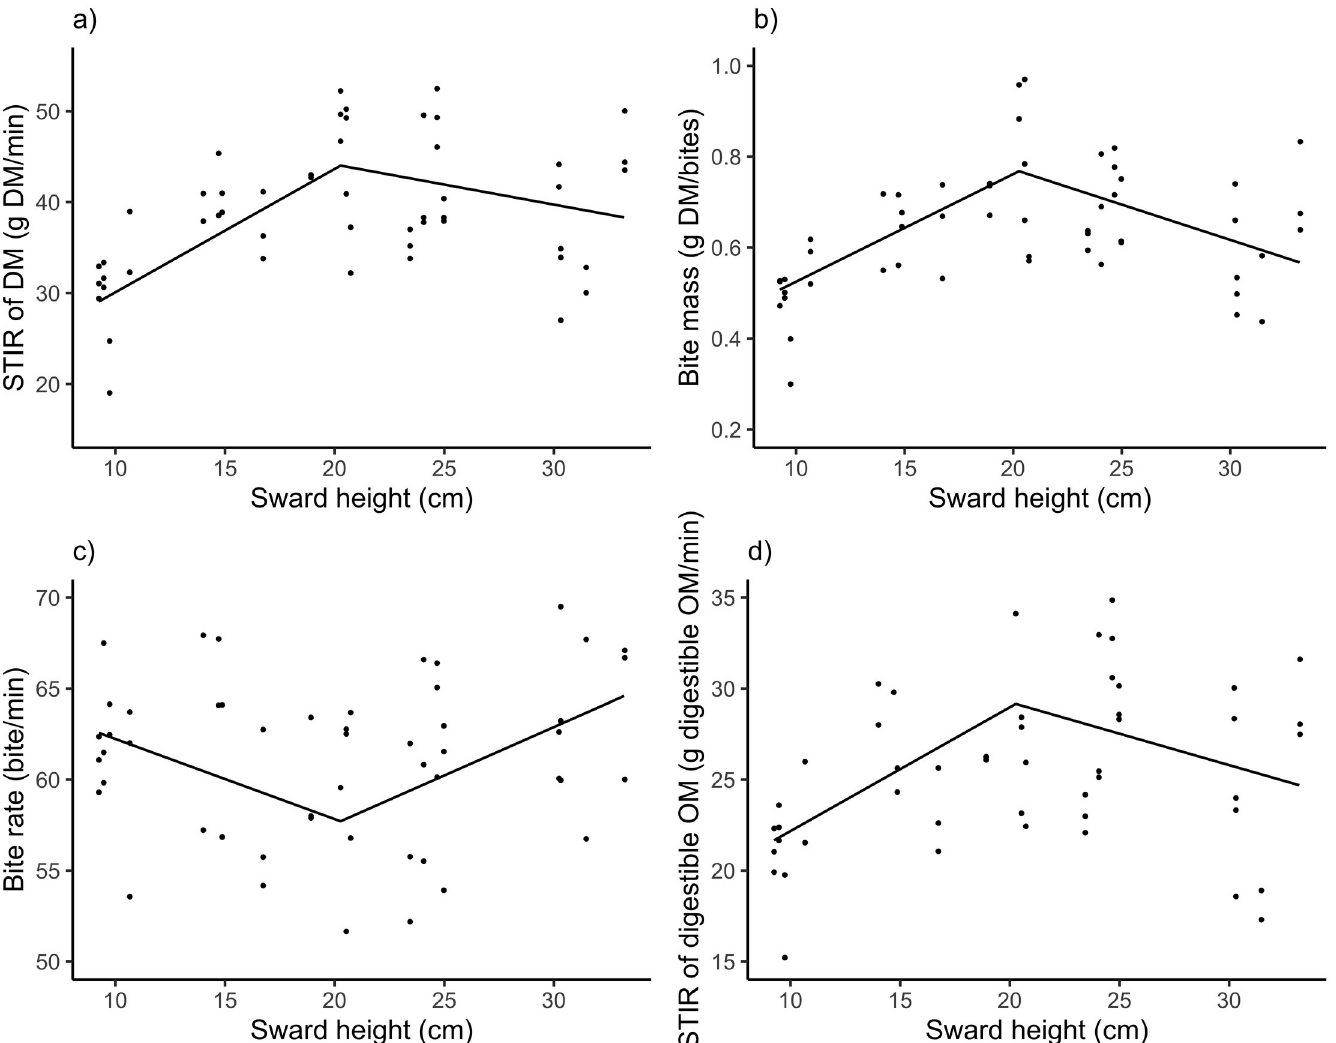
Fig 2. Relationships between ingestive behavior variables and sward height of Kikuyu grass. (a) Relationships between short-term intake rate of the dry matter (STIR of DM), (b) bite mass (BM), (c) bite rate (BR), and (d) short-term intake rate of digestible organic matter (STIR of digestible OM) of dairy heifers as a function of sward height (SH) in monoculture of Kikuyu grass ( Cenchrus clandestinus— Hochst. ex Chiov). Equation for STIR of DM = min(44 + 1.36 (SH– 19.3), (44–0.44 (SH– 19.3)), P < 0.001, R 2 = 0.35; BM = min(0.77 + 0.023 (SH– 20.9), (0.77–0.016 (SH– 20.9), P 0.001, R 2 = 0.36; BR = min(57.71–0.44 (SH– 20.3); (57.71 + 0.53 (SH– 20.3), P < 0.009, R 2 = 0.14; STIR of digestible OM = min((29.16 + 0.68 � (SH– 20.3); (29.16–0.34 � (SH– 20.3)), P < 0.001, R 2 = 0.21.